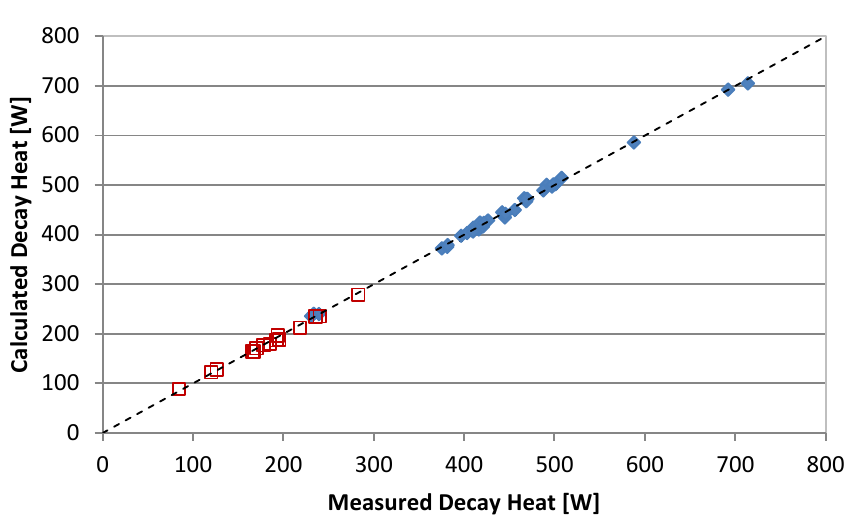
Figure 1. Comparison of C/E between CLAB measurements and CMS5/SNF (BWR assemblies – red squares; PWR assemblies – blue